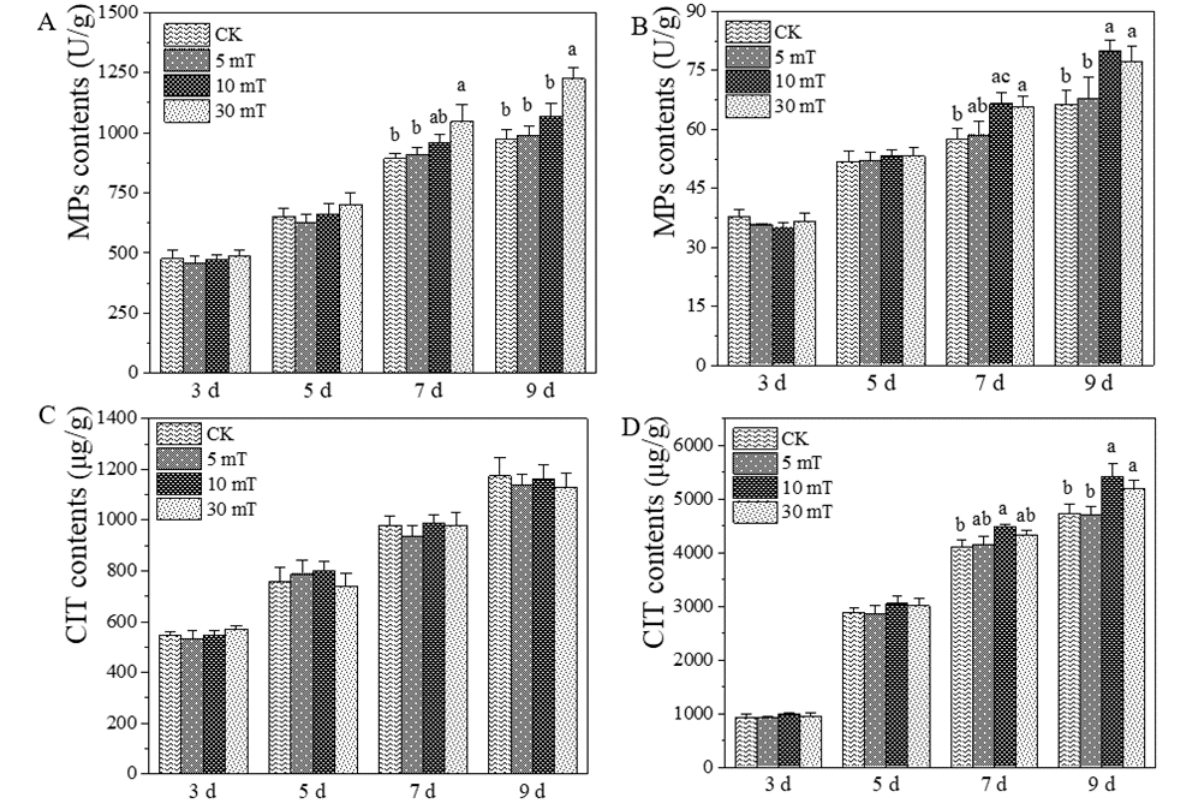
Figure 2. Monascus pigments (MPs) and citrinin (CIT) produced by M. ruber M7 under the static magnetic field. ( A ). The intracellular MPs; ( B ). The extracellular MPs; ( C ). The intracellular CIT; ( D ). The extracellular CIT. The error bars indicate the standard deviations of three independent cultures. Lowercase letters signify a p -value < 0.05. Table 1. Quality analyses of the transcriptomic data from M. ruber M7 treated under 30 mT static magnetic field (SMF). Total Raw Samples Reads